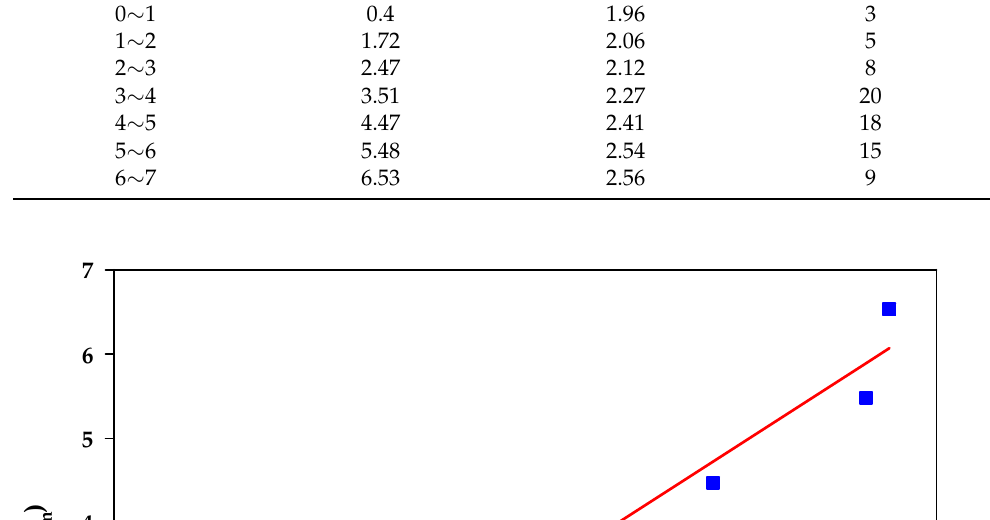
Table 6. Results for grouping K f /K m data.